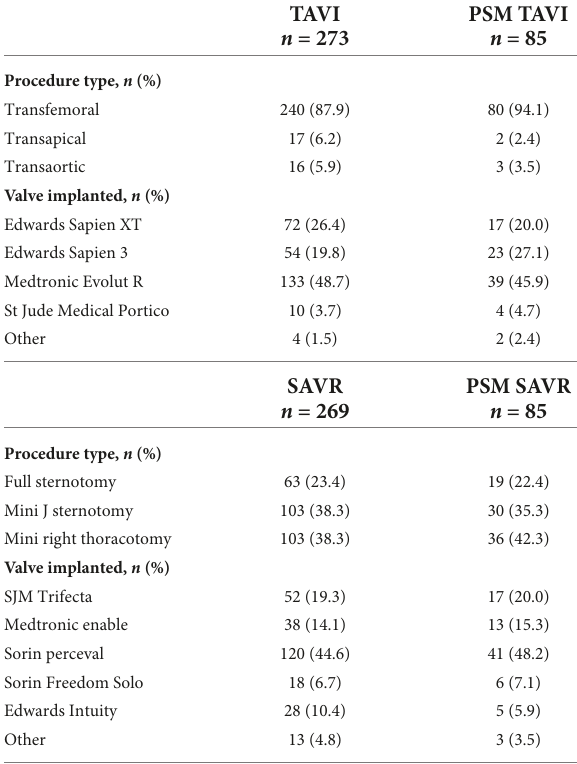
TABLE 2 Perioperative data according to TAVI or